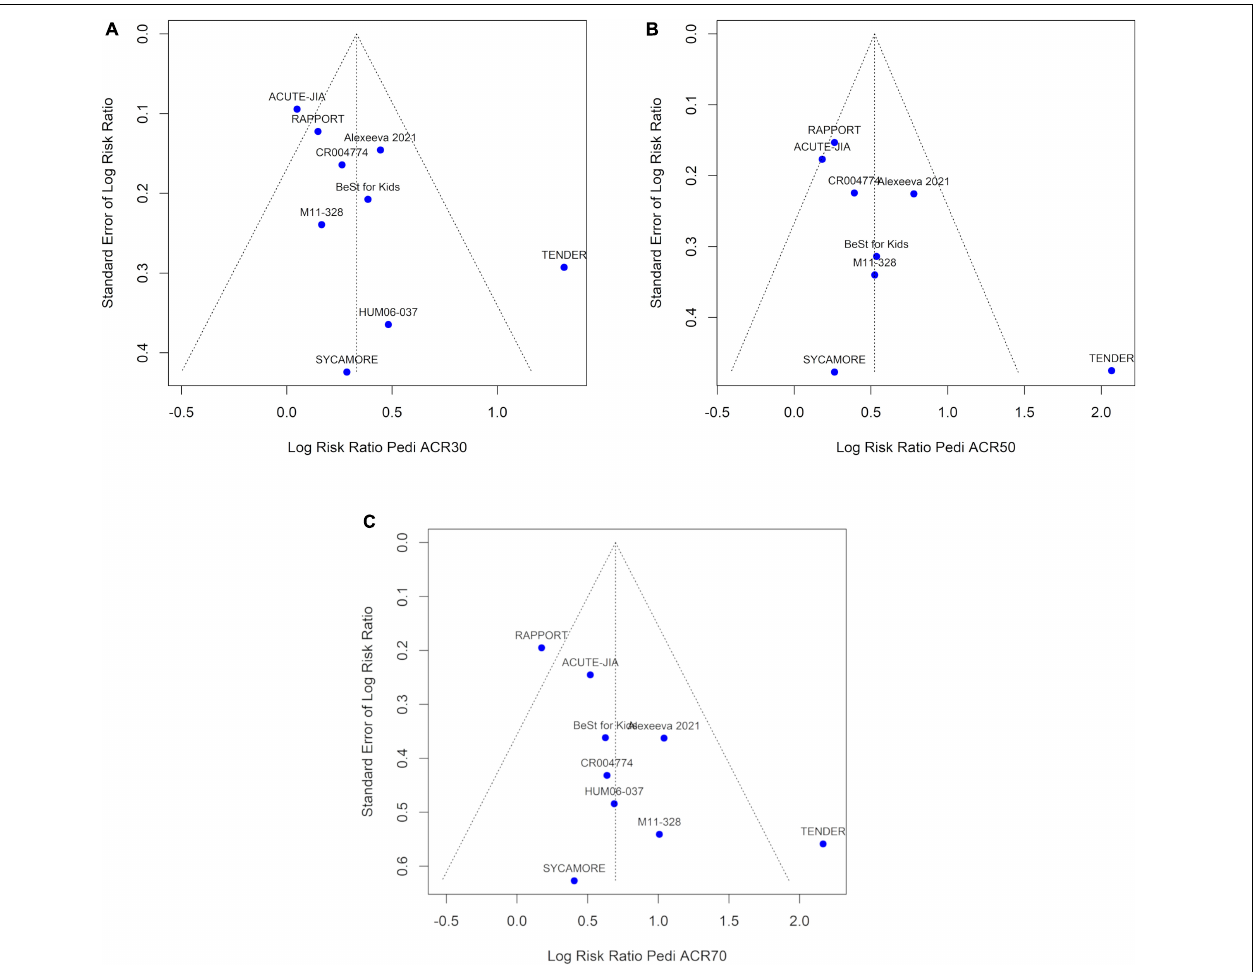
FIGURE 2 | Funnel plots asymmetry tests, using data from (A) ACR Pedi 30 data (B) ACR Pedi 50 data (C) ACR Pedi 70 data, with log-risk ratios displayed on the horizontal